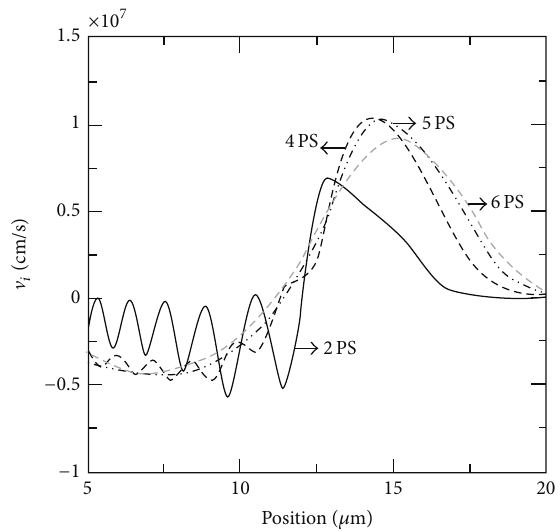
Figure 7: Ion velocity profiles at times 2, 4, 5, and 6PS after irradiation of a 4PS neodymium glass laser pulse on a deuterium plasma of initial density of a linearly increasing ramp (abscissa in micrometer of the depth, with critical density at 13) of 30 eV temperature, confirming the generation of an ablating plasma block (negative velocity) and a compressing plasma block (positive